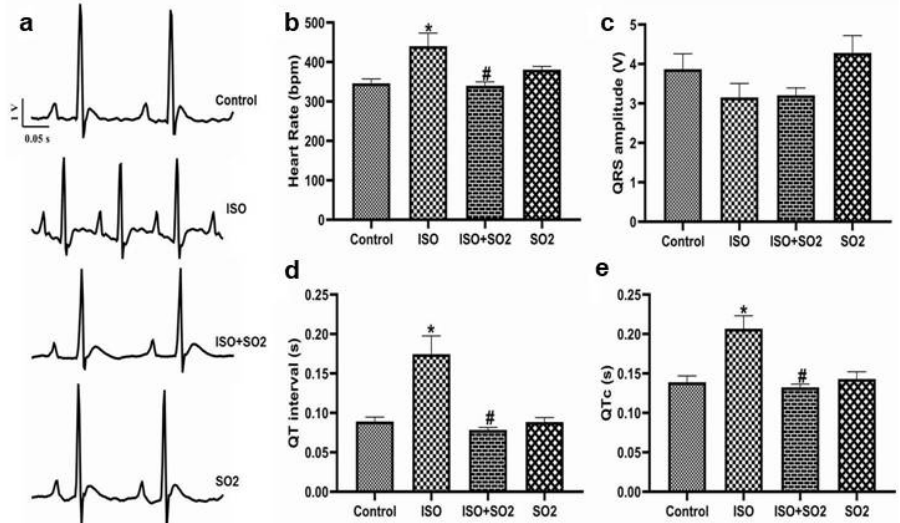
Figure 1. ECG characteristics of experimental groups. Representative ECG signals of heart recorded from each experimental groups (a). Heart rate (b) was elevated in ISO compare to control groups, while ISO+SO2 was lowered to control levels. QRS amplitude (c) was not changed between groups. QT interval (d) demonstrated that ventricular repolarization time was elevated in ISO compare to control group, also reduced in ISO+SO2 compare to ISO group. The QTc (e) parameter also shows same pattern of QT changes. Values are means ± SEM. *p< 0.01 versus Control; #p< 0.01 versus